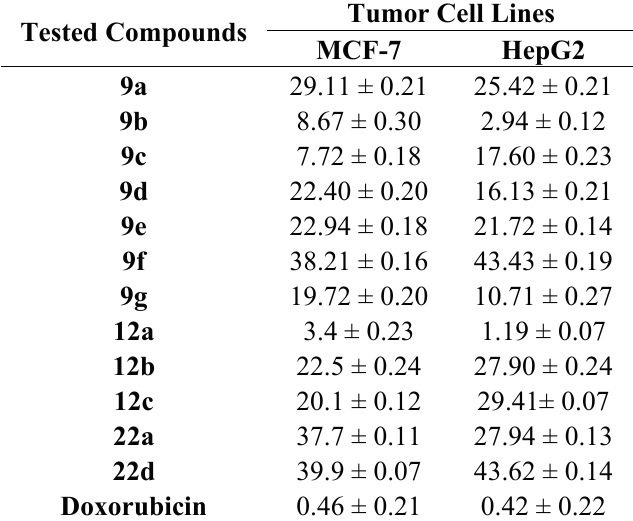
Figure 1. Antitumor activity of thiazoles and 1,3,4-thiadiazoles. Table 1. The in vitro inhibitory activity of tested compounds against tumor cell lines expressed as IC 50 values ( μ M) ± standard deviation from six